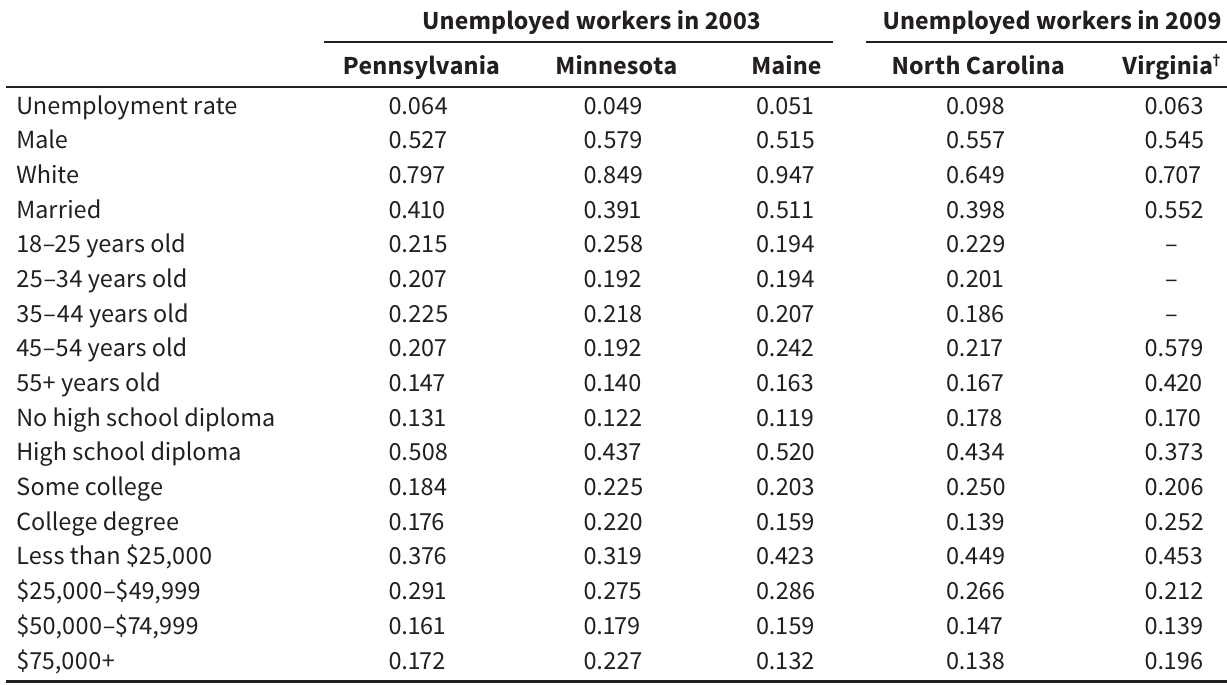
Characteristics of unemployed